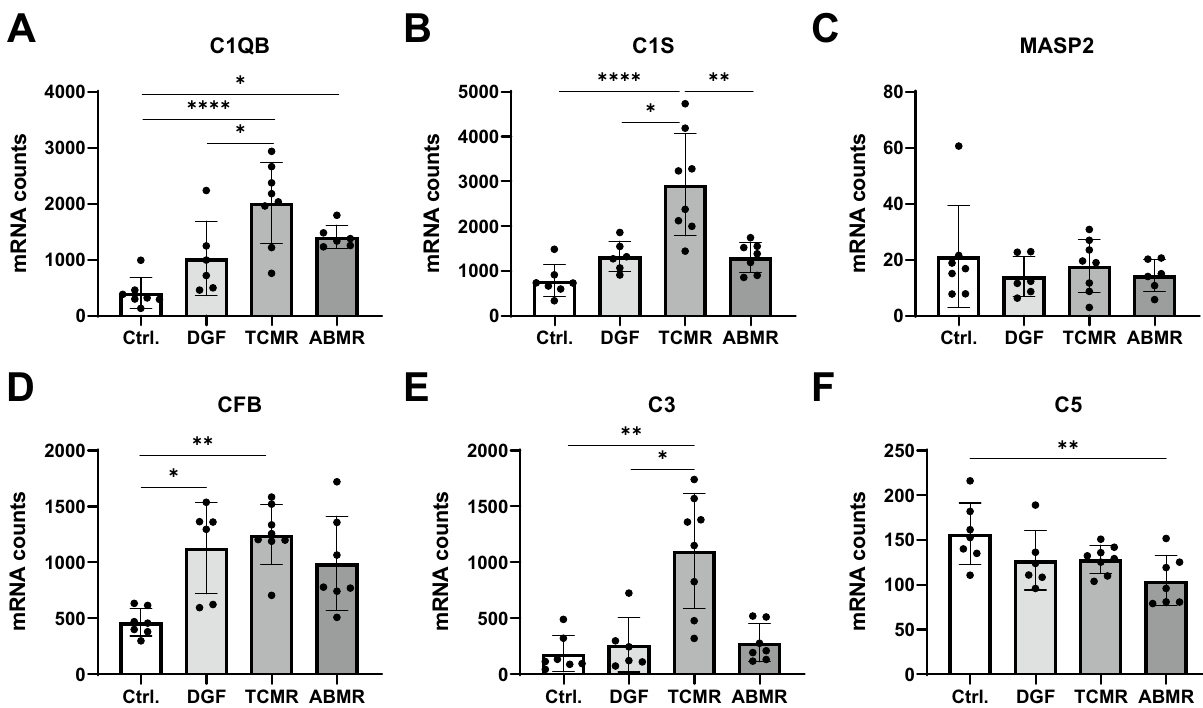
Ctrl. Figure 1. Expression analysis of complement initiator molecules and factors. Number of mRNA molecules coding for the initiator molecules C1QB ( A , ABMR n = 6), C1S ( B ), MASP2 ( C , ABMR n = 6) and CFB ( D ), and the complement factors C3 ( E ) and C5 ( F ) in follow-up biopsies of renal transplants with no rejection or dysfunction (Ctrl), delayed graft function (DGF), T-cell mediated rejection (TCMR) or antibody mediated rejection (ABMR); (Statistical analysis: A , B , F : ANOVA with Tukey’s; C – E : Kruskal–Wallis with Dunn’s; *p < 0.05; **p < 0.01; ***p < 0.001; ****p <